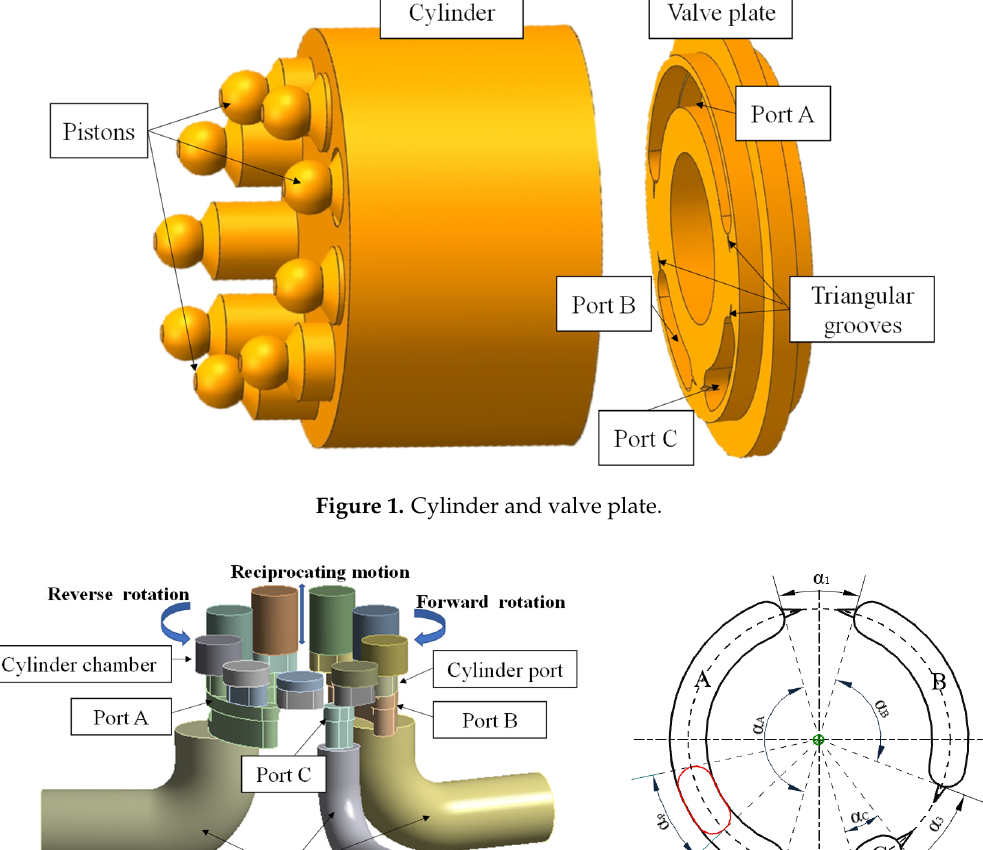
Figure 2. Fluid domain model of three-port piston pump. ( a ) Three-dimensional fluid domain. ( b ) Three-port valve plate structure.